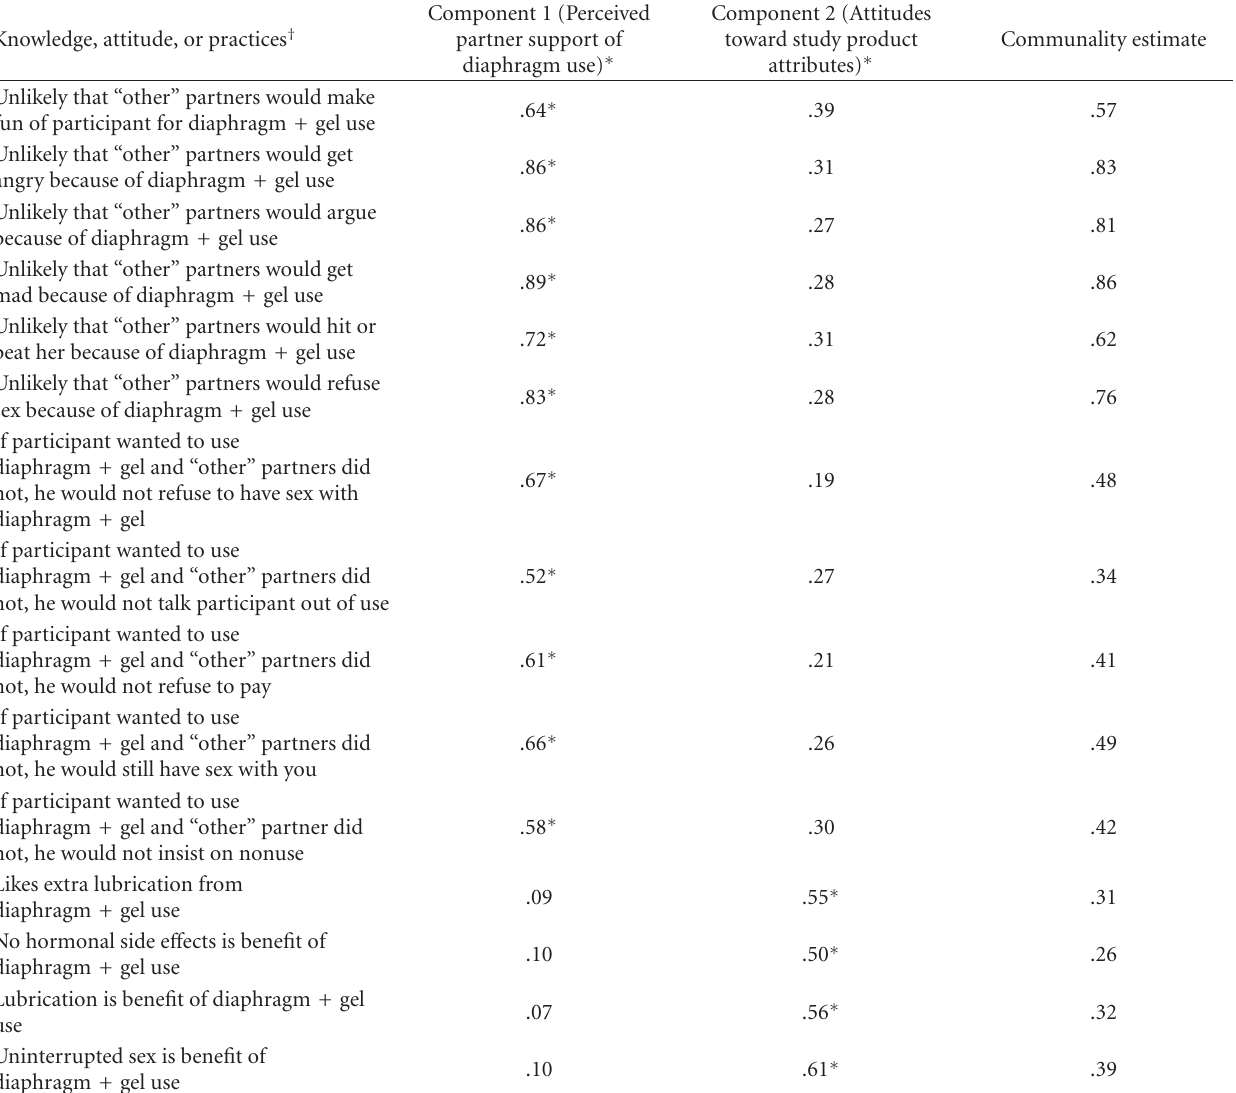
Table 4: Rotated factor pattern and final communality estimates from principal component analysis of participants’ (and perception of partners’) knowledge, attitude, or practices regarding diaphragm use with “other” partners, Nairobi, Kenya, 2004-2005 ∗